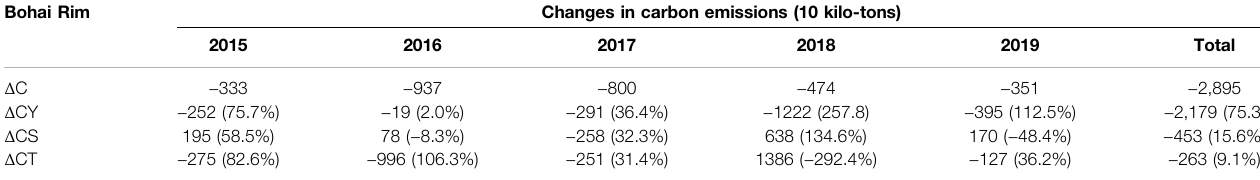
TABLE 4 | Decomposition of carbon emission factors in the Bohai